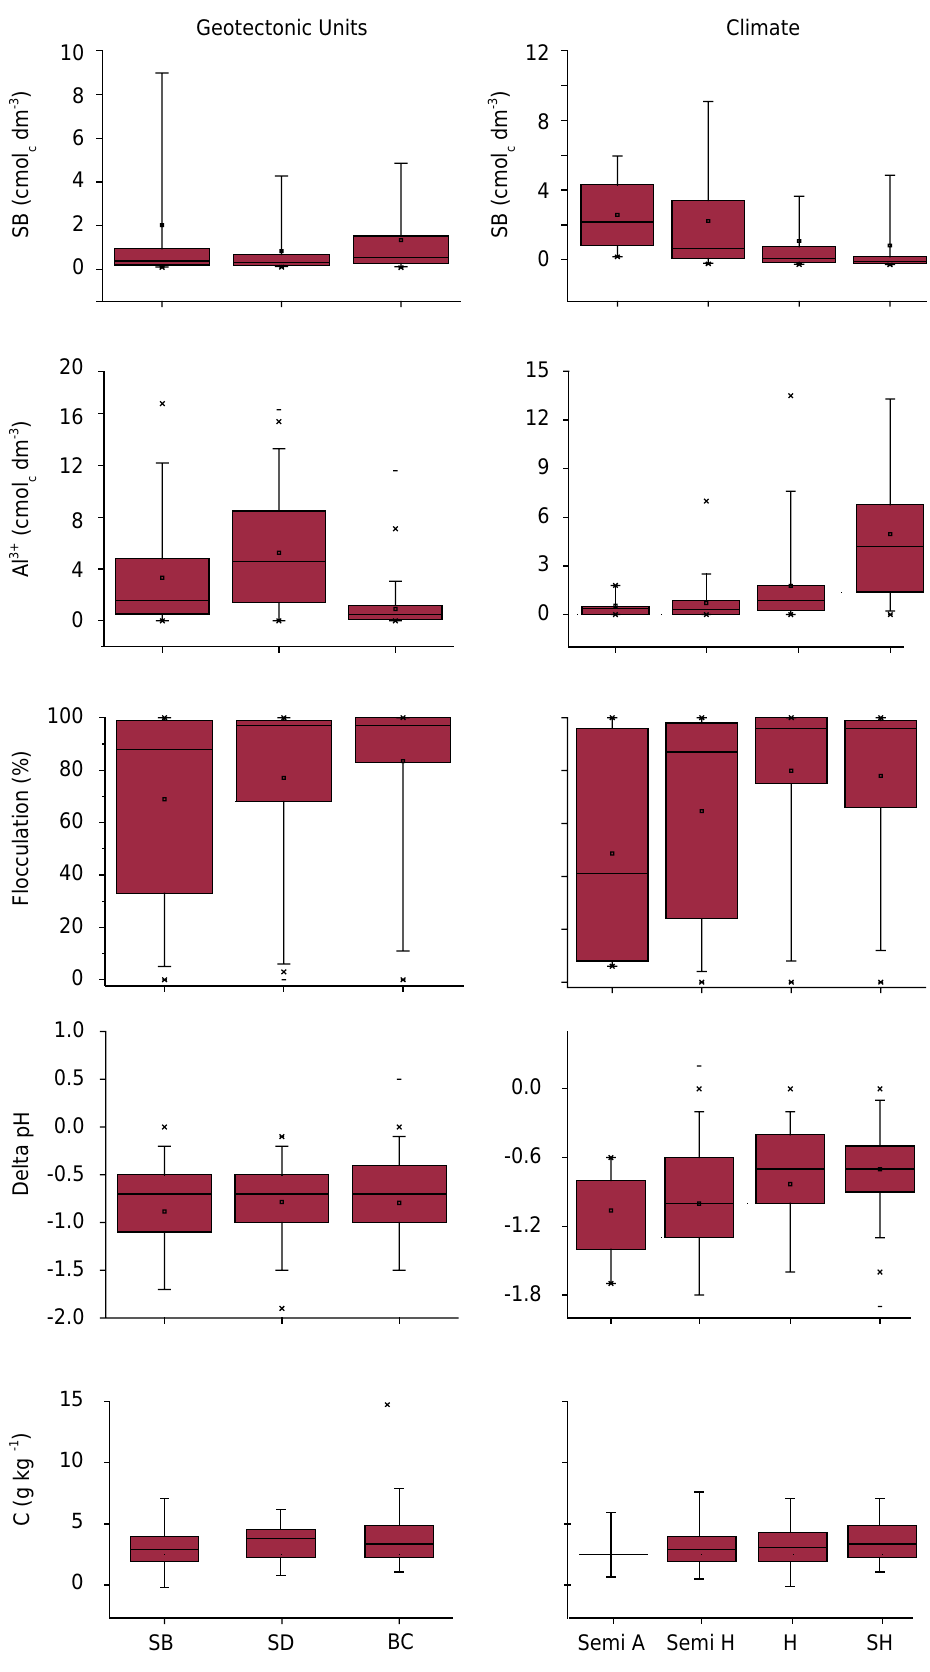
Figure 3. Mean, median, 1st, and 3rd quartile, near and distant outliers, maximum and minimum values of the variables among the groups of morphostructural domains: SB = sedimentary basins; SD = sedimentary deposits; BC = basement complex. Climate units: SemiA = semi-arid; SemiH = semi-humid; H = humid; SH = super-humid. SB = sum of bases (cmol c dm -3 ); Al 3+ = exchangeable aluminum (cmol c dm -3 ); Flocculation = degree of flocculation (%); C = organic carbon (g kg -1